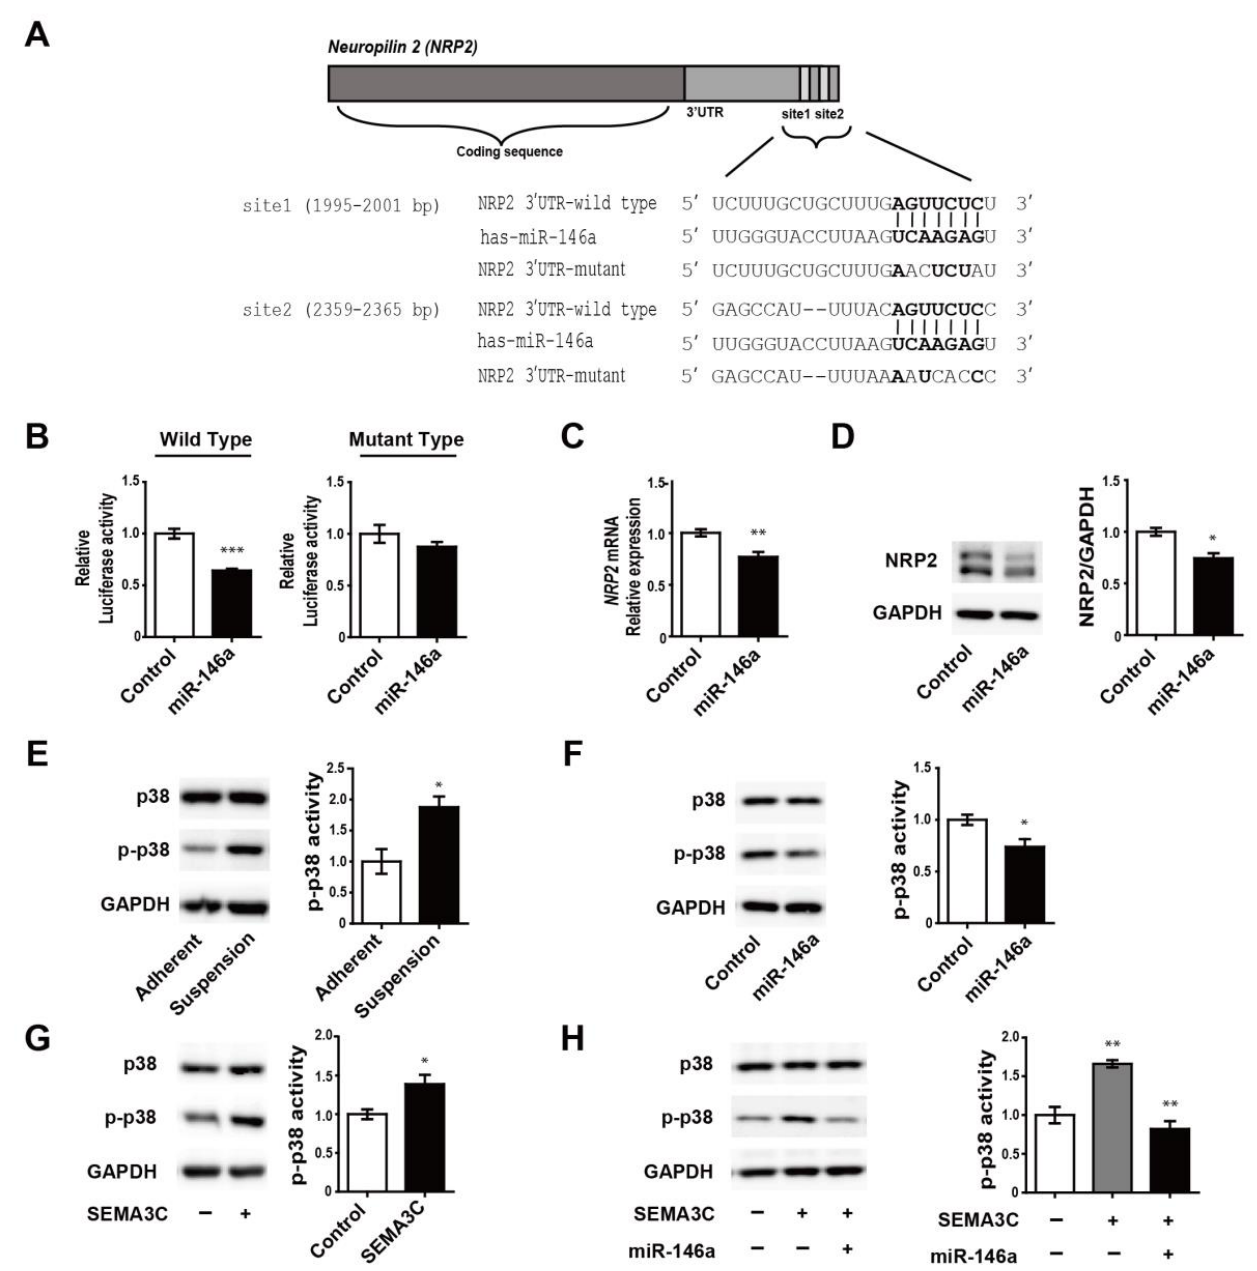
Figure 3. MiR-146a regulation of NRP2 expression (through binding NRP2 3 (cid:48) UTR) and reduction in SEMA3C-mediated Figure 3 phosphorylation of p38 (p-p38) level. ( A ) Predicted sequences of NRP2 3 (cid:48) UTR targeted by miR-146a and mutated sequences to disrupt the recognition of miR-146a. ( B ) Luciferase activity after the overexpression of miR-146a in HeLa cells transfected with a reporter construct containing either the wild-type or mutagenized type 3 (cid:48) UTR of NRP2 . ( C , D ) NRP2 mRNA and protein expression in response to the overexpression of miR-146a in MDA-MB-468 suspension cells. ( E ) Activity of p-p38 in adherent and suspension cells ( F ) Activity of p-p38 in response to the overexpression of miR-146a in suspension cells. ( G ) Activity of p-p38 after treatment of suspension cells with SEMA3C (50 ng/mL). ( H ) Activity of p-p38 in response to SEMA3C (50 ng/mL) overexpression miR-146a or non-overexpression control culture in suspension cells. * p < 0.01, ** p < 0.001, and *** p < 0.0001 compared to controls calculated via an unpaired two-tailed Student’s t -test. Error bars denote the standard error of the